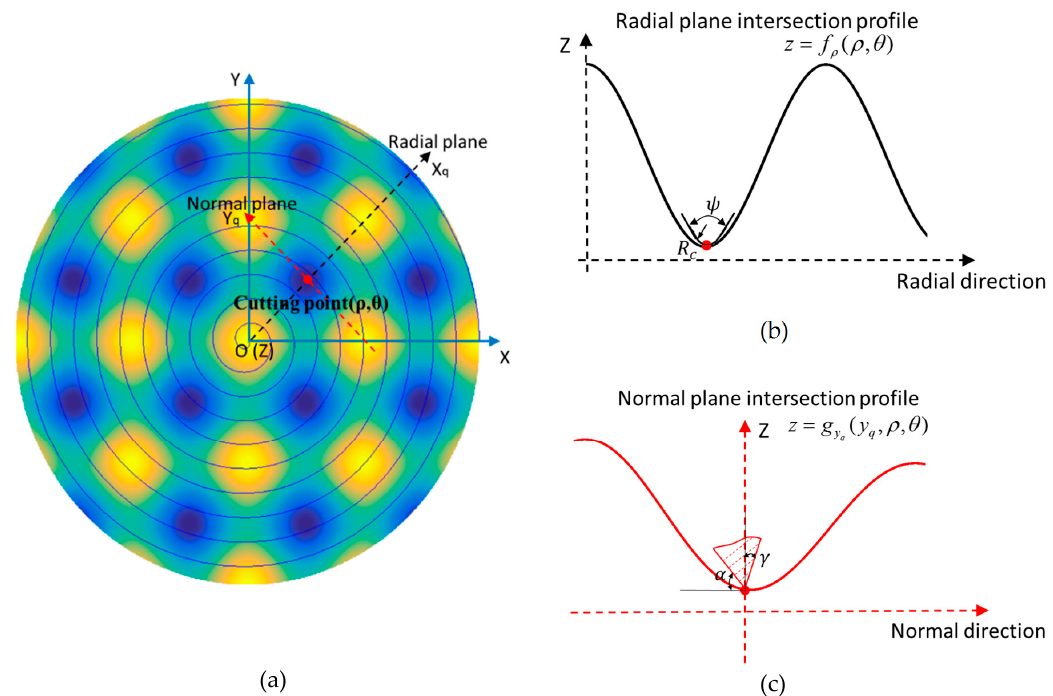
Figure 5. Schematic of tool geometry selection for STS freeform machining. ( a ) Radial and normal cutting plane; ( b ) Radial sectional profile; ( c ) Normal sectional profile.